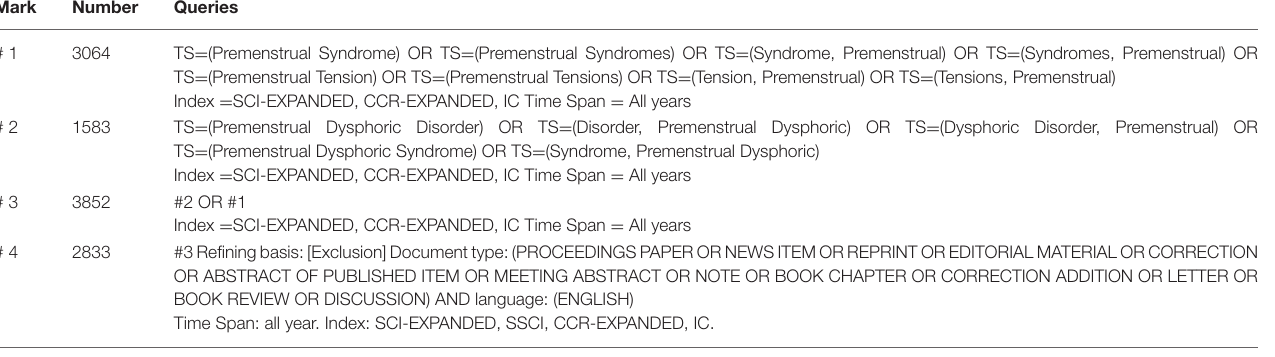
TABLE 1 | Search queries for premenstrual syndrome and premenstrual dysphoric disorder. Mark